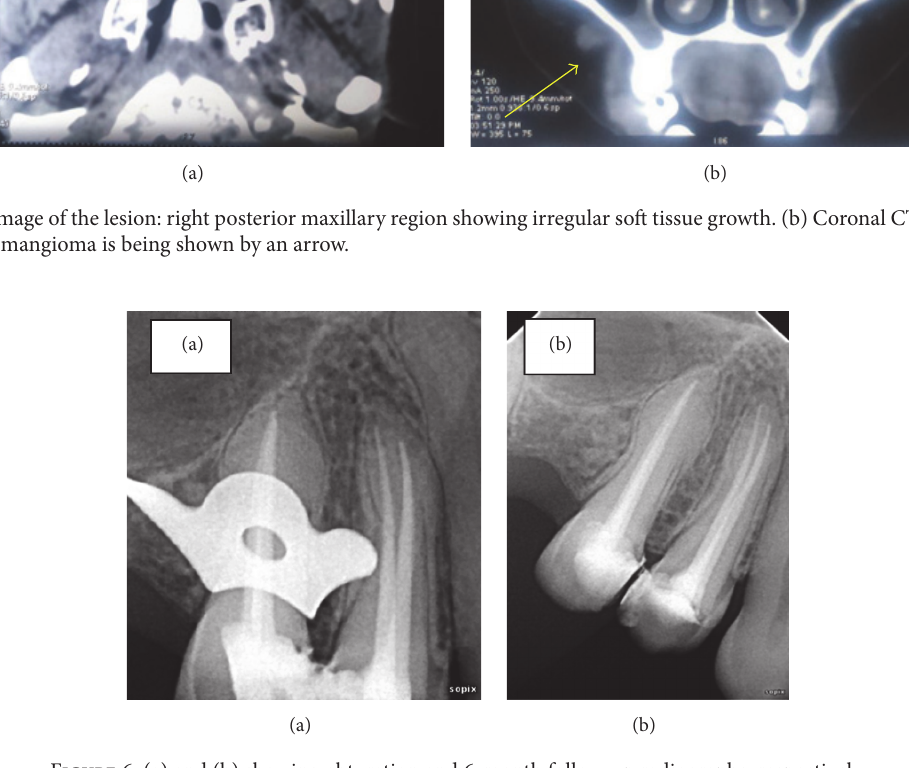
Figure 6: (a) and (b) showing obturation and 6-month follow-up radiographs,